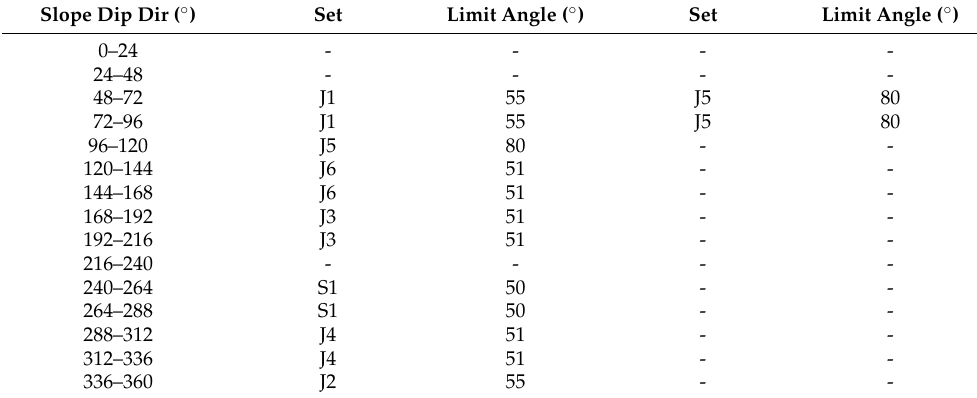
Table 6. Kinematic stability analysis results: planar sliding.